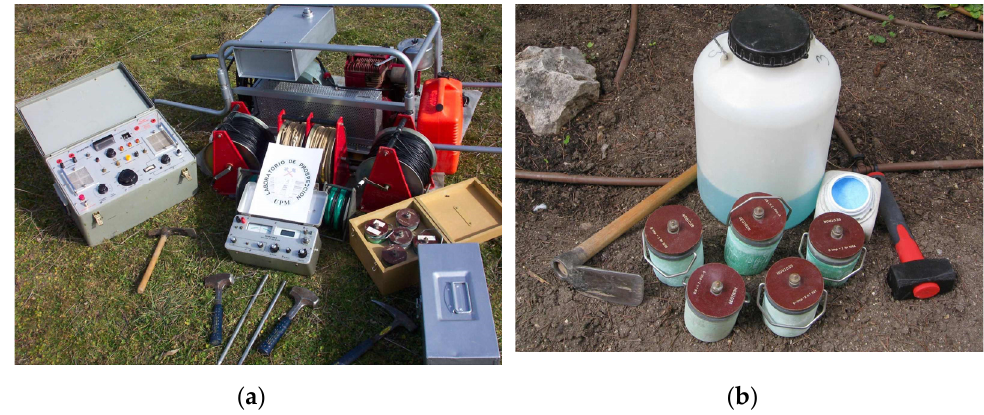
Figure 2. ( a ) Scintrex TSQ-3 equipment and IPR-10A receiver. ( b ) Fat non-polarisable electrodes with CuSO 4 .